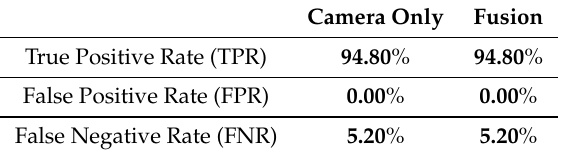
Table 6. Fusion performance: 20 to 40-m range. The best results in bold.